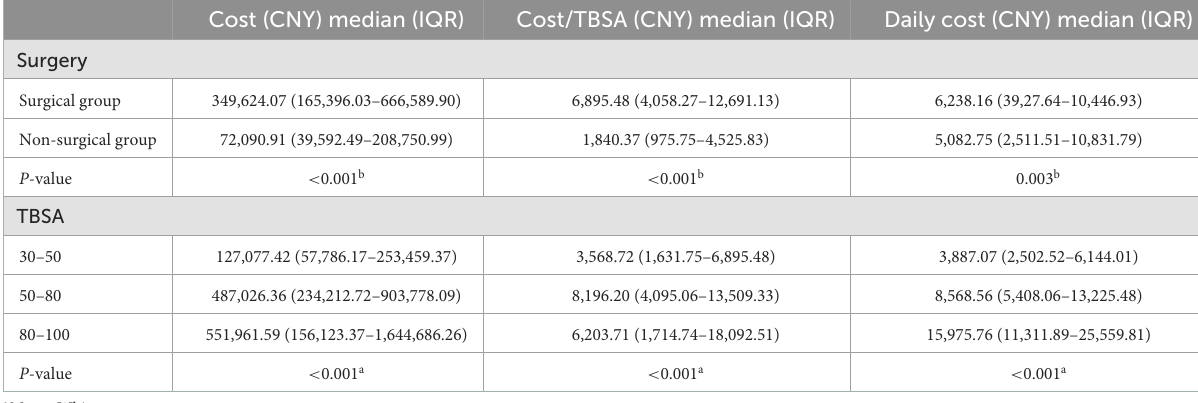
TABLE 5 Analysis of cost, classified by with or without surgery and burn area.